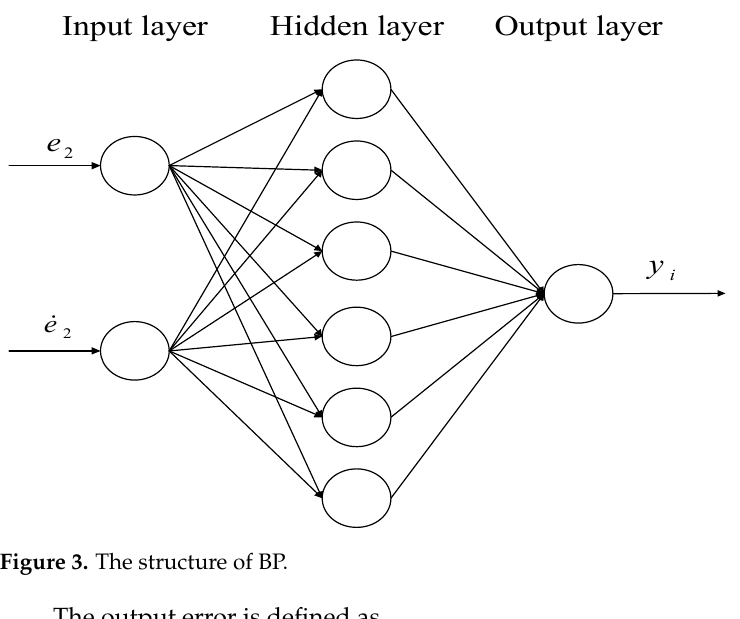
Figure 3. The structure of BP.